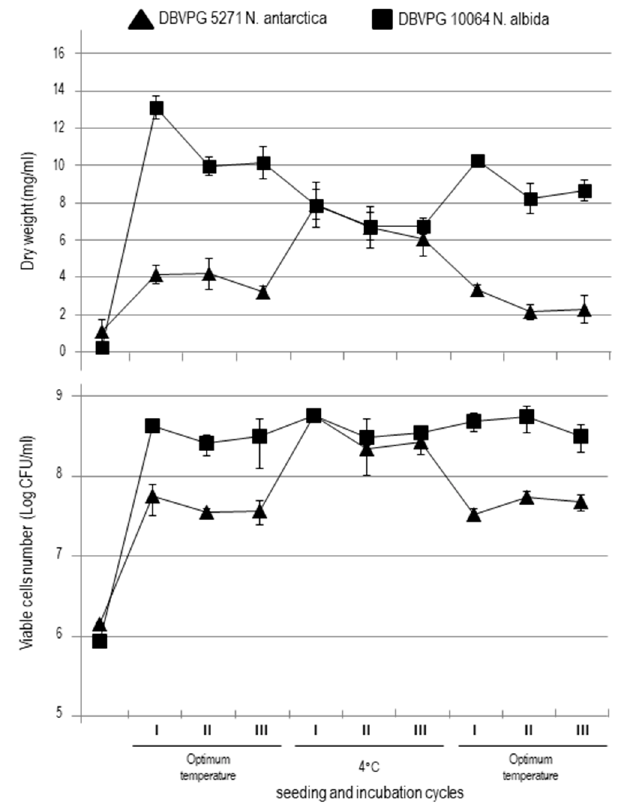
Figure 2. Time course of cell growth of N. antarctica DBVPG 5271 and N. albida DBVPG 10064 during the seeding and incubation cycles. Dry weight and viable cell number were shown. Error bars indicate the SEM.